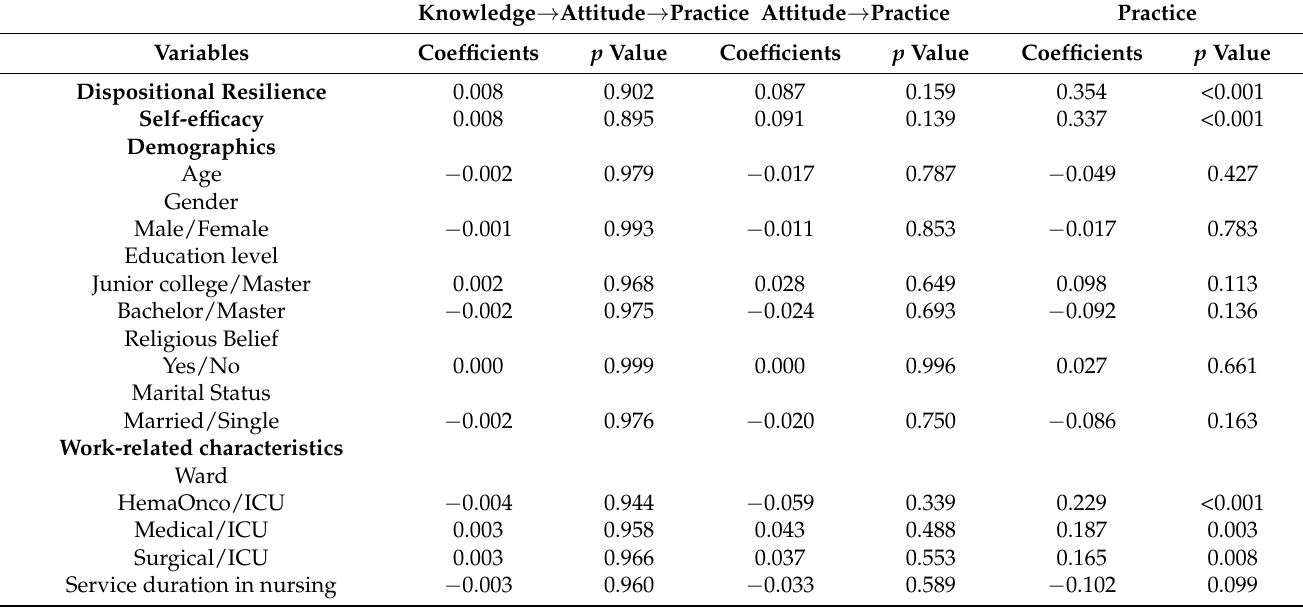
Table 4. Path modeling for knowledge, attitude, and practice of ACP of terminally ill patients among nurses (N =